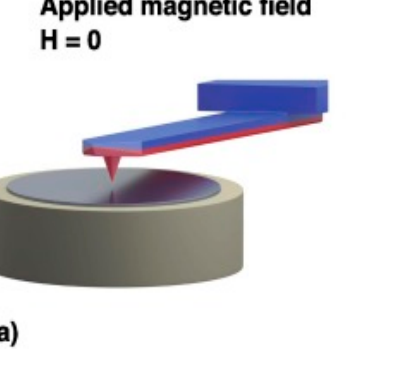
Figure 2. Working scheme of the setup. ( a ) At H = 0, the cantilever (blue) coated with the magnetostrictive film (red) is straight; the tip is engaged to the sample surface (the light blue disk), and the AFM piezoelectric scanner (gray) is in its default position. ( b ) At H > 0, the bimorph bends upward. ( c ) The AFM feedback causes the piezoelectric scanner to retract, until the cantilever is straight again, keeping the deflection point constant. The representation is not to scale and the increased tip–sample distance is exaggerated. For interpretation of the references to color in this figure legend, the reader is referred to the web version of this article [64] reprinted with permission from